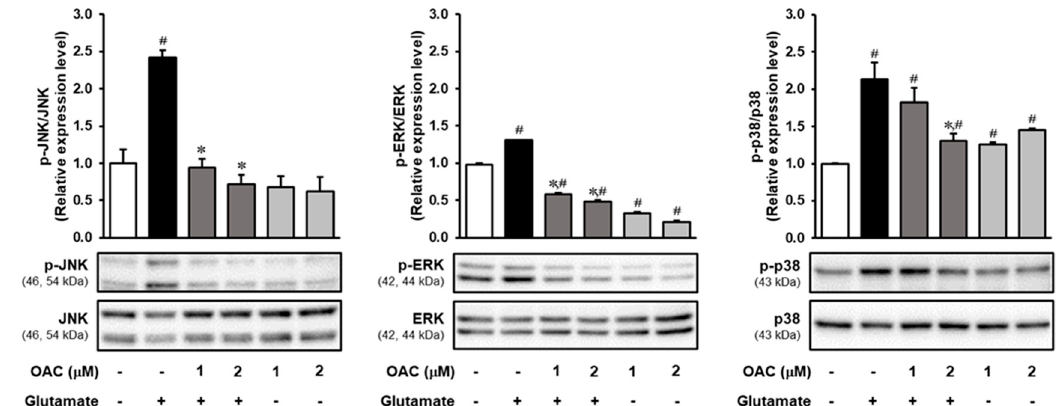
Figure 4. Inhibitory effect of OAC on the phosphorylation of MAPKs. OAC: osmundacetone; MAPKs: mitogen-activated protein kinases; JNK: c-Jun NH2-terminal kinase; ERK: extracellular signal-regulated kinase; ∗ p < 0.05 vs. glutamate-treated group; # p < 0.05 vs. non-treated group.